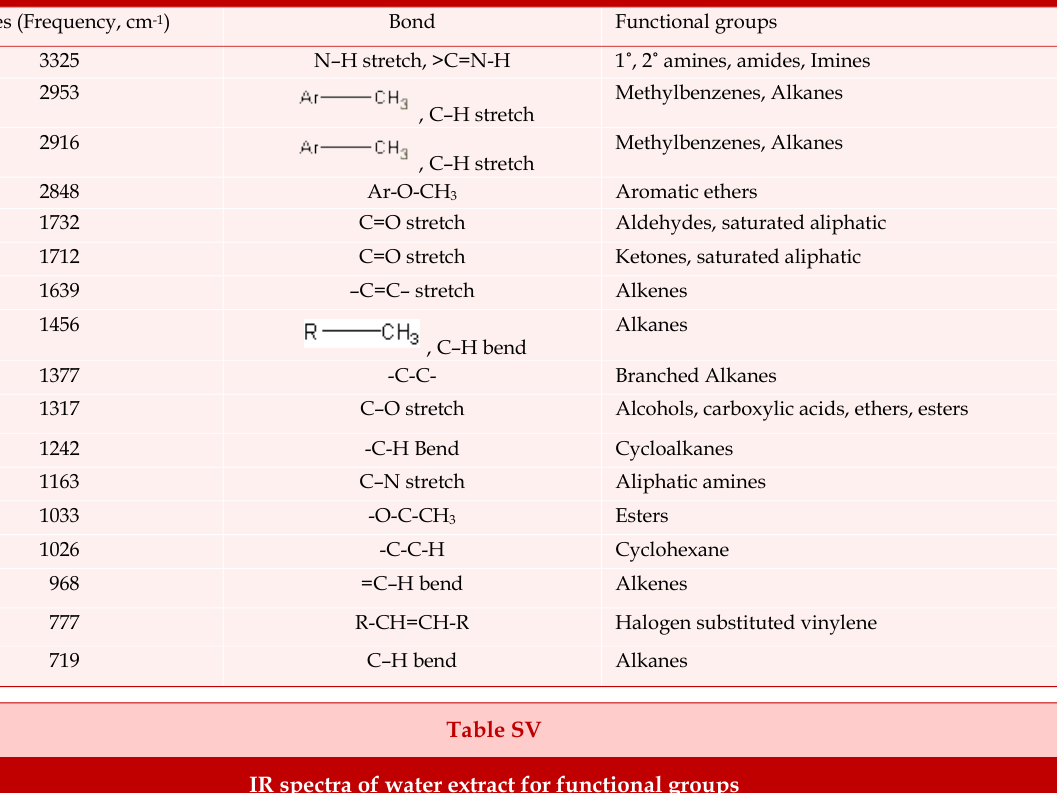
IR spectra of water extract for functional groups IR values (Frequency, cm -1 ) Bond Functional